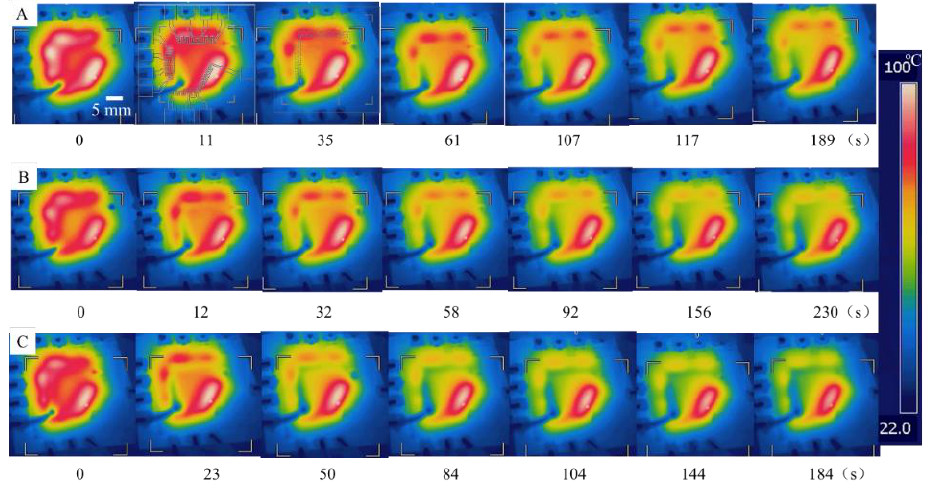
Figure 7. Cooling a working chip with coolant flow rates at 800 ( A ), 1200 ( B ), 2000 ( C ) µ